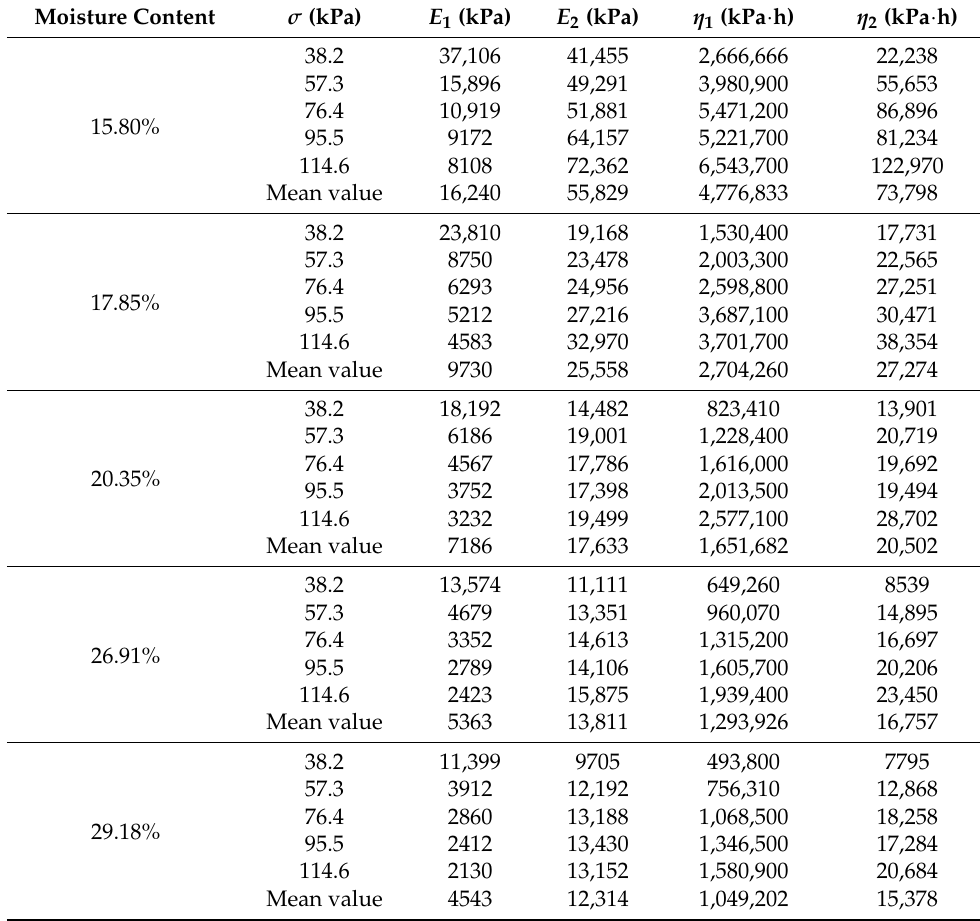
Table 3. Creep model